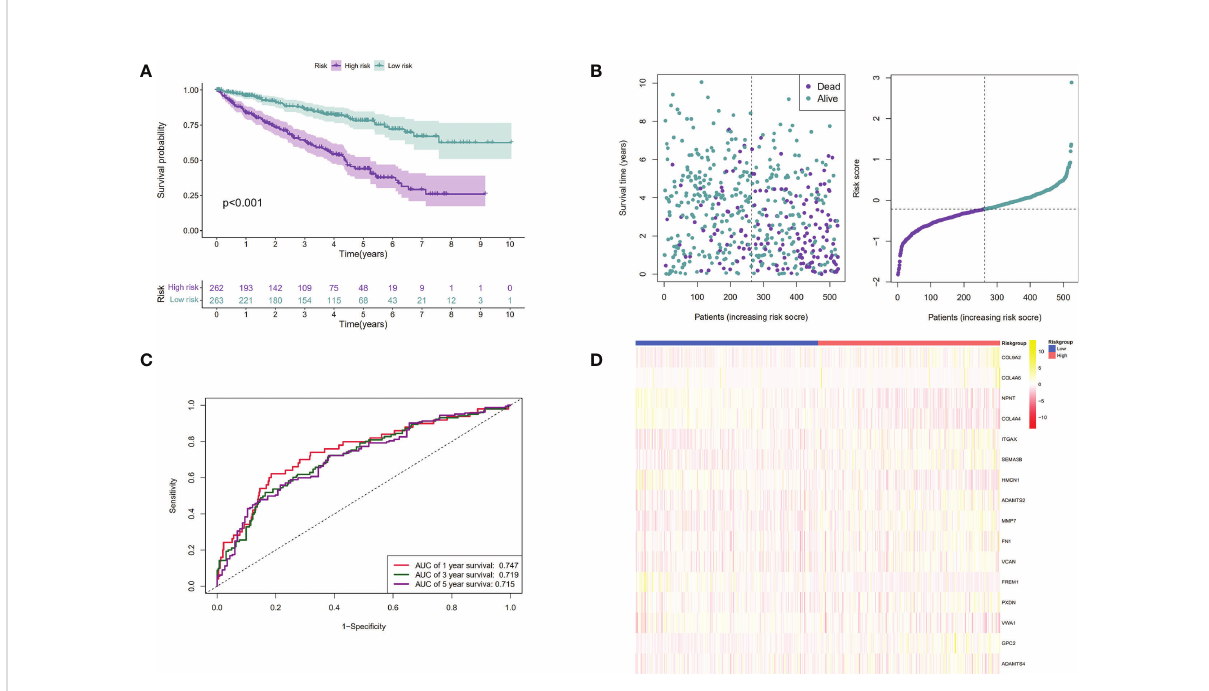
FIGURE 4 Establishment of the BM genes-based prognostic signature based on the TCGA dataset. (A). The Kaplan-Meier (K-M) curves of low-risk and high-risk ccRCC patients in the TCGA dataset; (B). The time-dependent ROC curves displaying the 1-year, 3-year, and 5-year OS of ccRCC patients in the TCGA dataset; (C). Survival distributions of the TCGA dataset determined according to the median risk score; (D). Heatmap displaying the divergences between low- and high-risk patients of 16 signature genes in the prognostic model for the TCGA